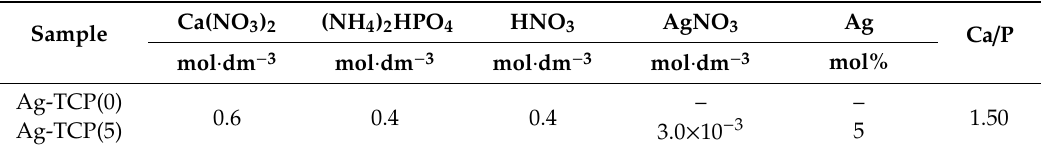
Table 1. Quantities of reactants used in the